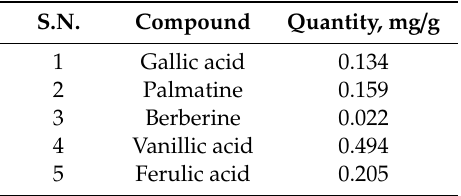
Figure 2. IC 50 curves of ( A ) aqueous extracts, ( B ) hydro-methanolic extract, ( C ) methanolic extracts, of different plant parts, and ( D ) HPLC analyzed components of T. cordifolia (methanolic fraction) with positive control (PC) against AChE. IC 50 values are shown in brackets. Experiments were performed in triplicates. PC (positive control), galantamine hydrobromide; Ts, Tinospora cordifolia (Giloy); Bm, Bacopa monnieri (Brahmi); Cp (S), Convolvulus pluricaulis (Shankhpushpi); Cp (M), Celastrus paniculatus (Malkagni), Ws, Withania somnifera (Ashwagandha). Table 2. HPLC analysis of Tinospora cordifolia (methanolic